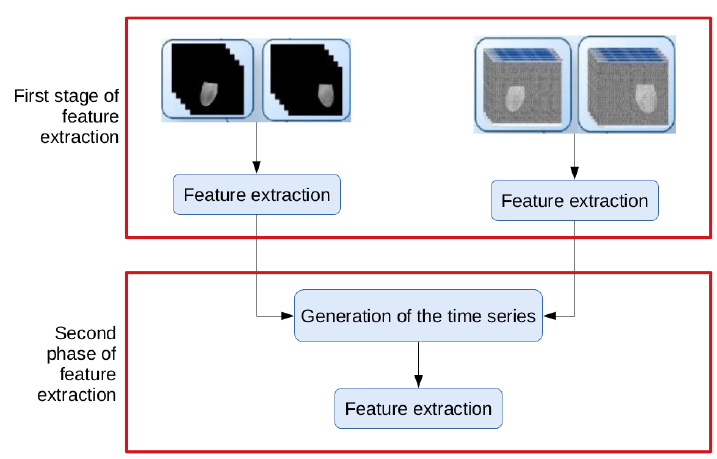
Figure 6. The two phases of the feature extraction.